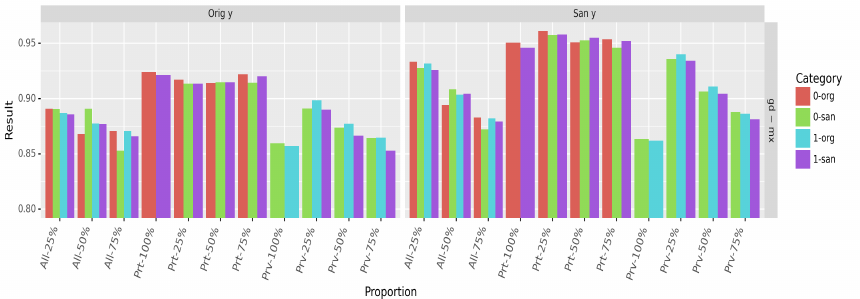
Figure 13. Accuracy of decision prediction on Adult dataset. With the proportion, the value oscillates between the minimum corresponding to the original data (86.25), and the maximum obtained using the complete sanitized set (96%). The standard deviation is below